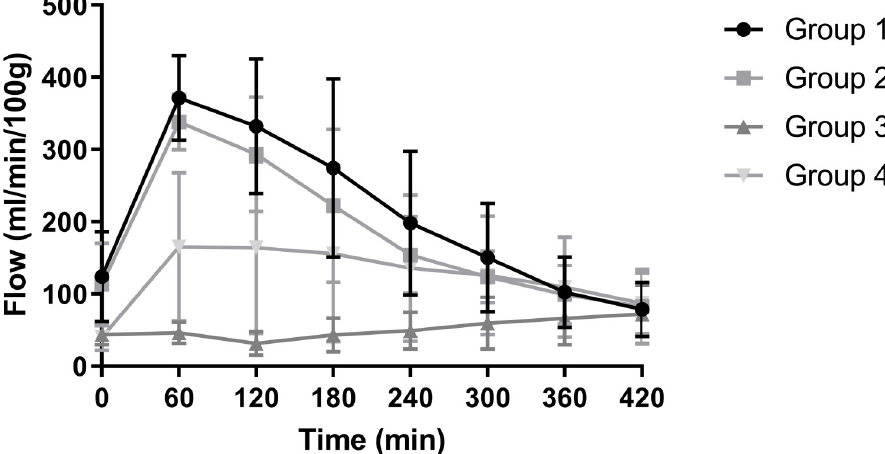
Fig 2. Renal arterial flow (ml/min/100g) of the four experimental groups during NMP (mean + SD).